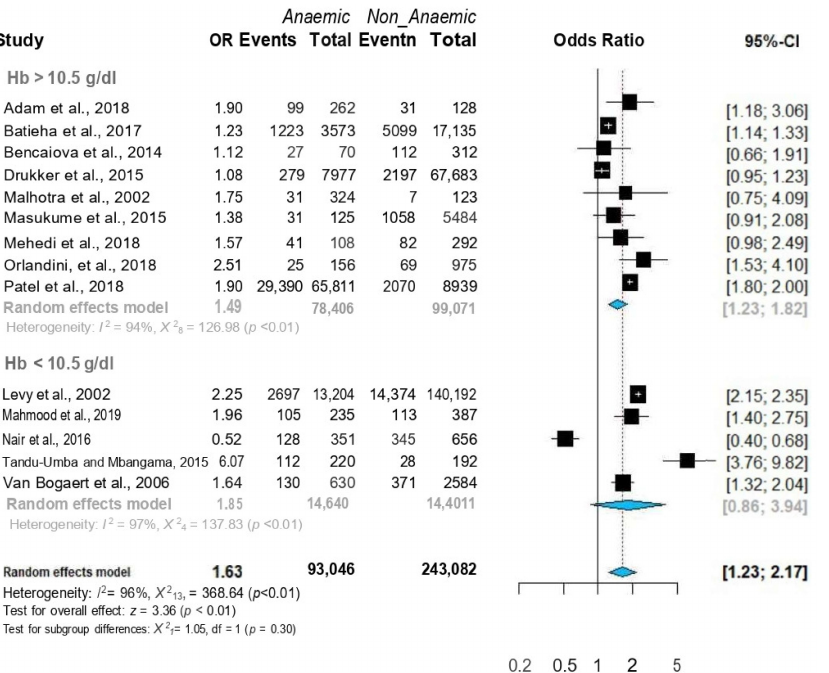
Figure 7. Forest plots of ORs with 95% CIs of the meta-analysis of the anaemia and caesarean delivery subgroup analysis according to Hb cut-off value. Published data from Adam et al. [27], Batieha et al. [25], Bencaiova et al. [26], Drukker et al. [10], Levy et al. [6], Mahmood et al. [28], Malhotra et al. [19] Masukume et al. [8] Mehedi et al. [20] Nair et al. [24] Patel et al. [9] Orlandini et al. [21] Tandu-Umba et al. [22] and Van Bogaert et al. [23] were used to calculate the pooled OR.